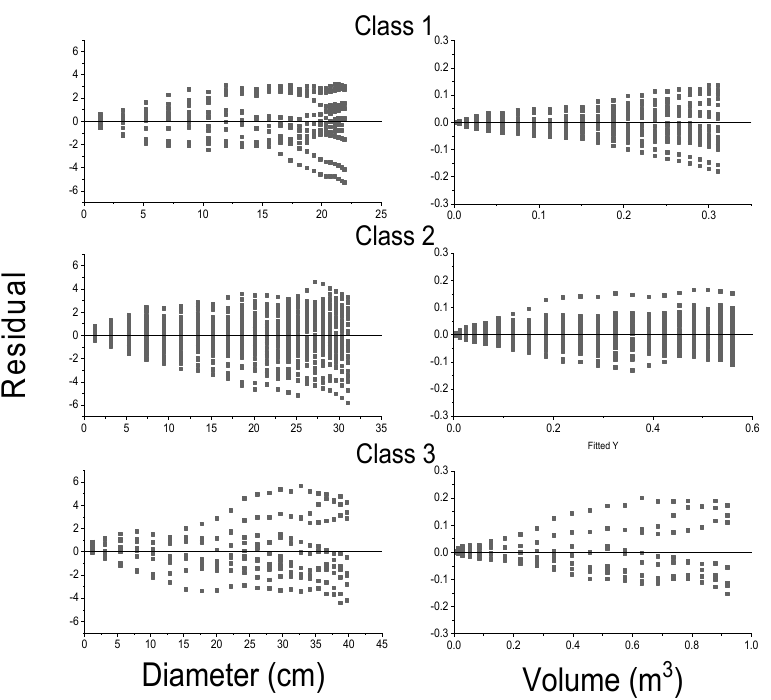
Figure A2. Cumulative DBH and wood volume of unthinned and thinned stands of fitted Equation (2) and their residuals.